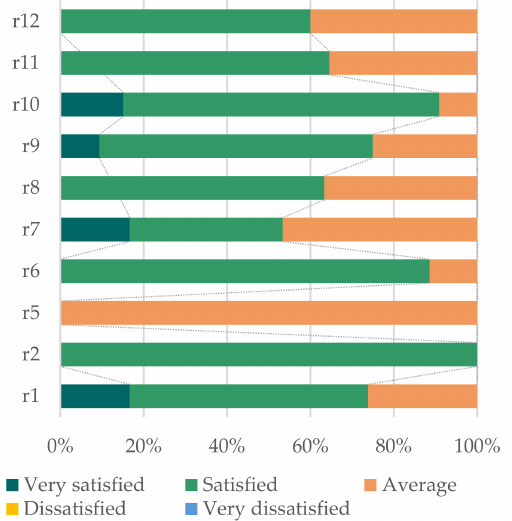
Figure A15. User satisfaction in Tianhe